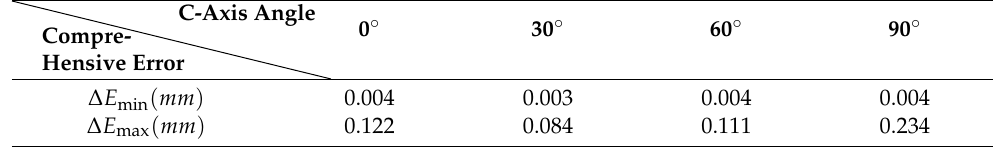
Table 5. The comprehensive error of the C-axis at each angle states when the A-axis = 0 ◦ .